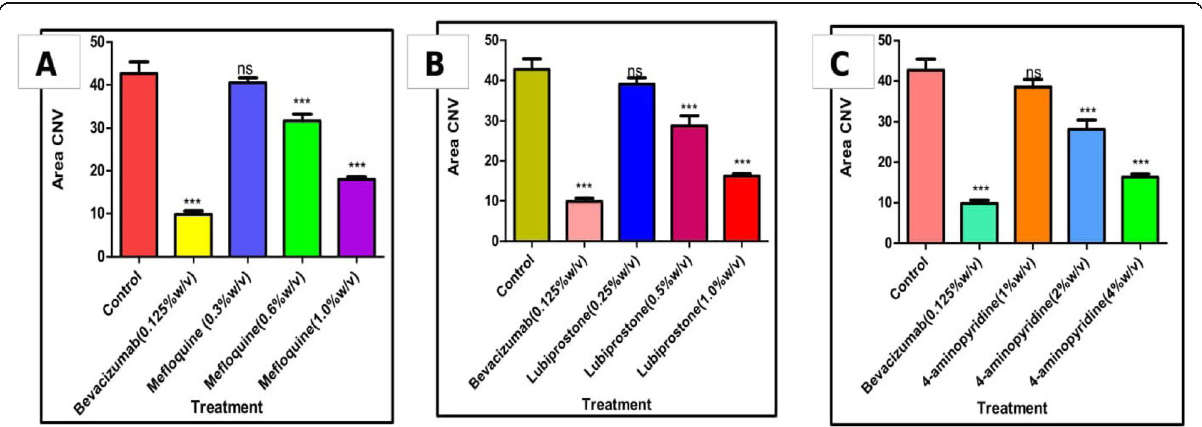
Fig. 1 Graph representing the effect of standard and test groups on area CNV. Results were presented as mean ± SEM. The differences between the groups were compared by one-way ANOVA followed by post hoc Dunnett ’ s test. In all the groups, n = 6. *** p < 0.001, ** p < 0.01, * p <